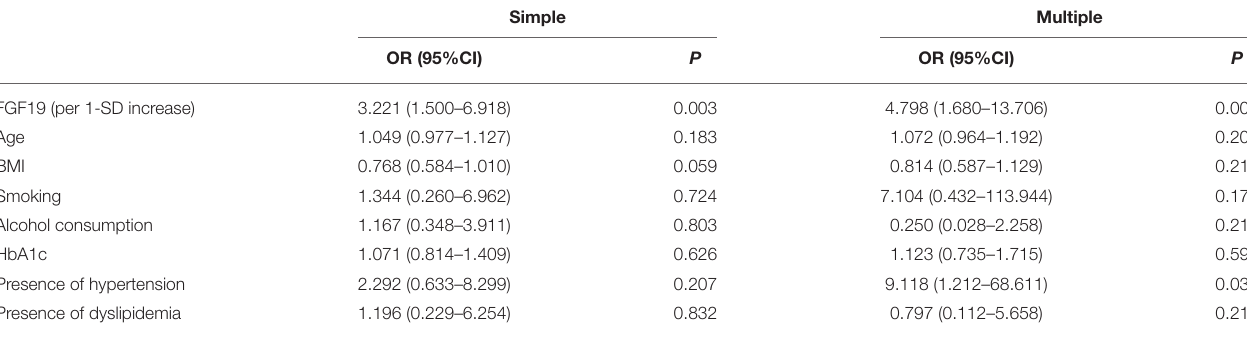
VariablesincludedinthemultiplelogisticregressionmodelareFGF19(per1-SDincrease),age,BMI,HbA1c,smoking,alcoholconsumption,presenceofhypertension,anddyslipidemia. BMI, body mass index; HbA1c, hemoglobin A1c; SBP, systolic blood pressure; DBP, diastolic blood pressure; FGF19, fibroblast growth factor 19; SD, standard deviation; subAS, subclinical